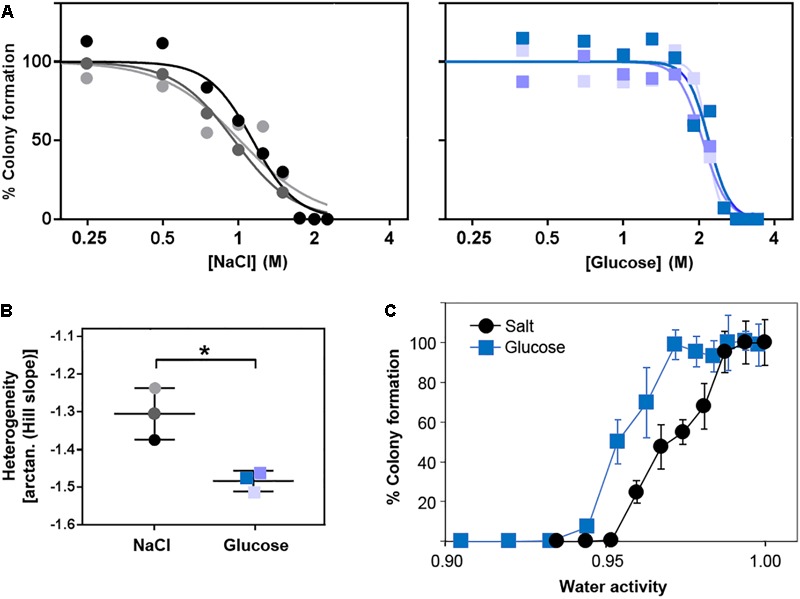
Heteroresistance of S. cerevisiae to chronic glucose or salt (NaCl) stress. S. cerevisiae BY4741 was cultured in YEPD broth then plated to YEPD supplemented with the indicated concentrations of glucose or NaCl. Colonies were enumerated after incubation for 28 days at 25°C. (A) Data are plotted as molar salt or glucose on a logarithmic scale, enabling Hill slope fitting for determination of heteroresistance (B) according to the kill-curve gradients. Different shaded symbols represent independent biological replicates. ∗p < 0.05 according to Welch’s t-test. (C) Data plotted against the corresponding water activities. Points are means from the three replicates ± SD.